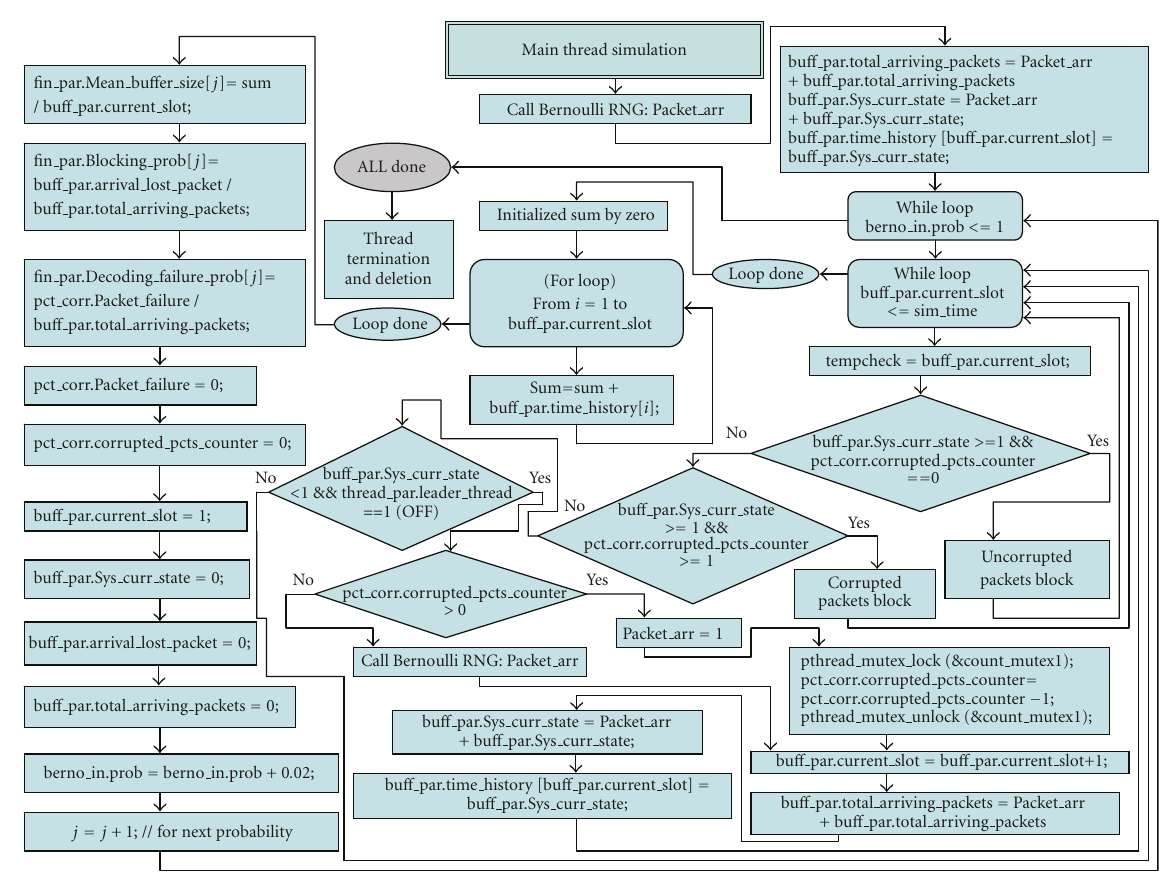
Figure 12: Major decoding steps for main